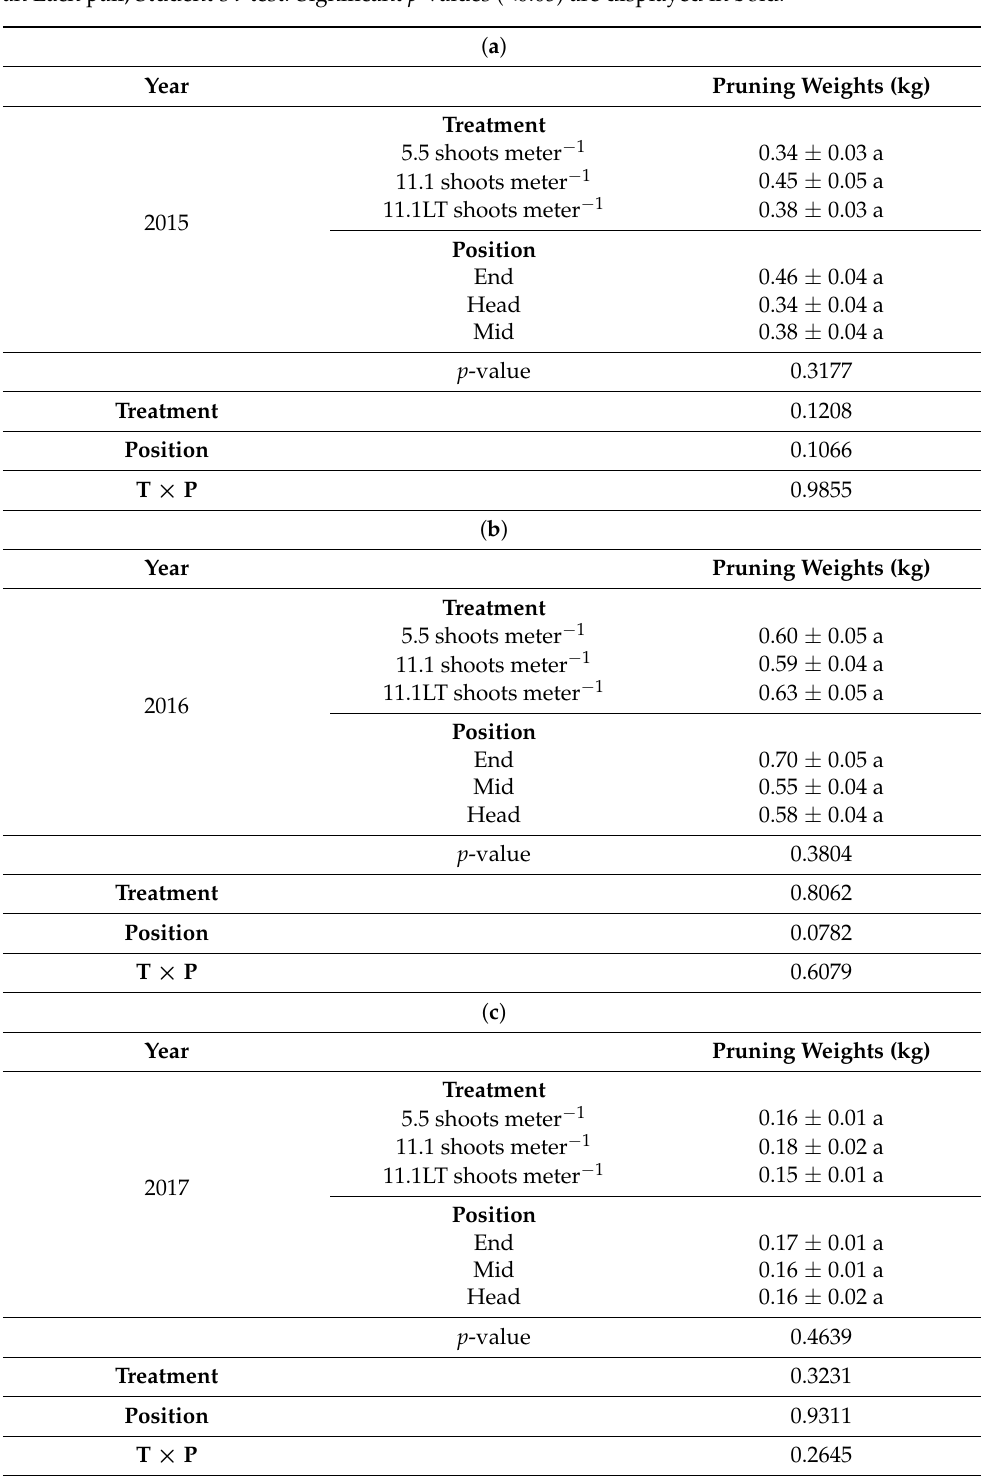
nodes per vine as in the mechanical pruning trials, this could be the reason no differences were observed. Table 9. Two-way analysis of variance (ANOVA) with interaction showing average pruning weights (kg) by year, treatment, and cordon position at harvest during the 2015 ( a ), 2016 ( b ), and 2017 ( c ) growing seasons ( n = 8). Table shows treatment and cordon position means followed by the standard error of the mean. Different letters within a column indicate significant differences based on an Each pair, Student’s t -test. Significant p -values (<0.05) are displayed in